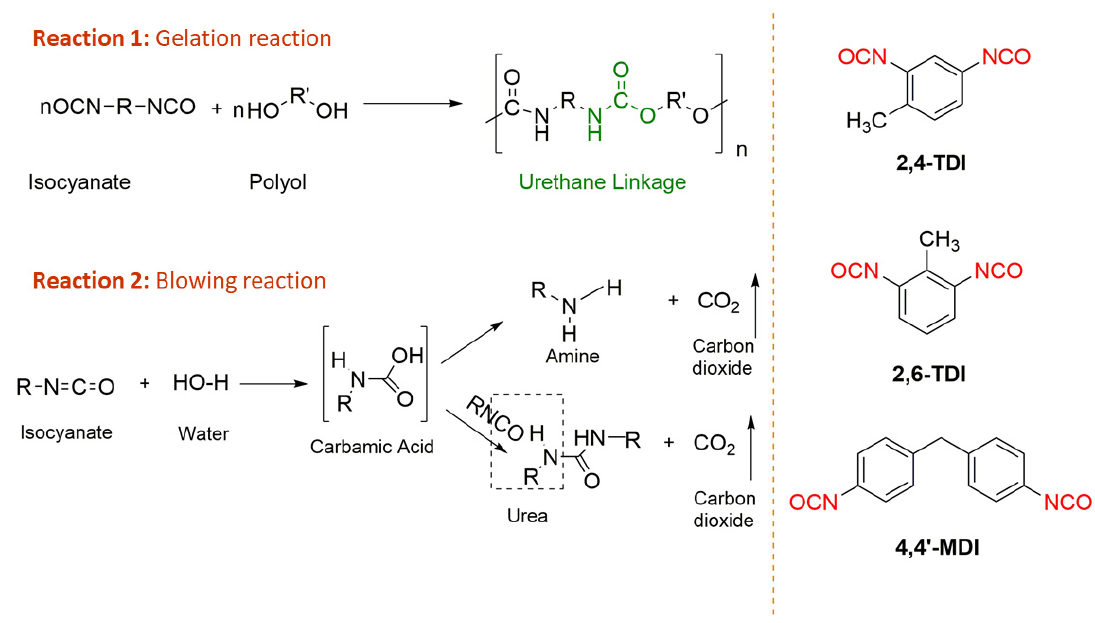
Figure 6. Schematic reaction of isocyanate and water (blowing agent) and the formation of urethane linkage and commonly used isocyanates (TDI and MDI).